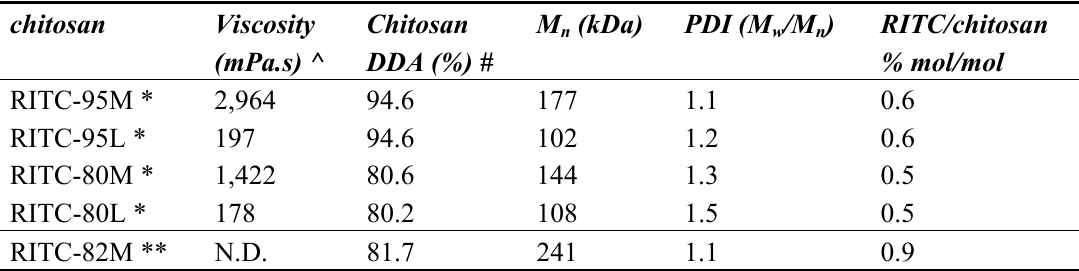
Table 2. RITC-chitosans used in the study.